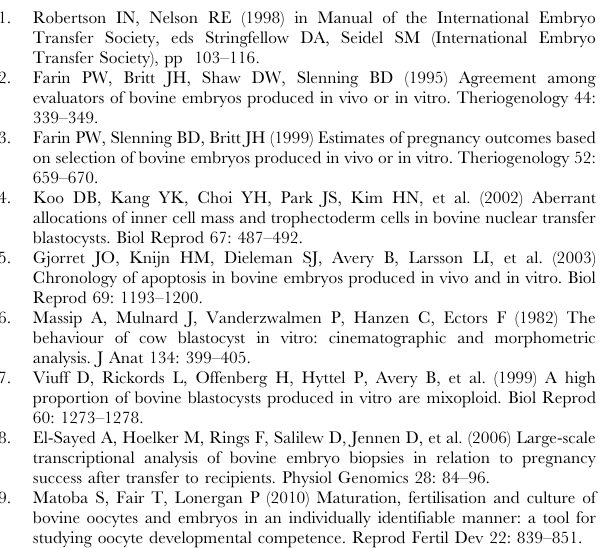
Table S4 Effect of oxygen tension on in vitro develop- ment of bovine IVF embryos cultured in microwell culture dish. Table S5 Multiple regression analysis of variables from blastocysts (n =173) reflecting cell number and cell allocation. Table S6 Logistic regression analysis of variables from blastocysts (n =195) reflecting hatchability. (DOC) Table S7 Multiple regression analysis of variables from blastocysts (n =74) reflecting apoptosis incidence. Table S8 Logistic regression analysis of variables from blastocysts (n =111) reflecting the karyotype. (DOC) Table S9 Multiple regression analysis of variables from blastocysts (n =75) reflecting gene expression. Table S10 Estimated probabilities derived from the fitted logistic regression model of pregnancy